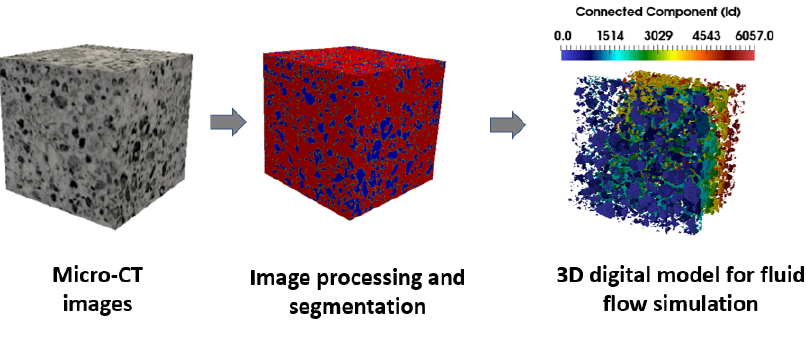
Figure 2. Workflow of the numerical simulation at pore-Scale of the micro-CT image of the